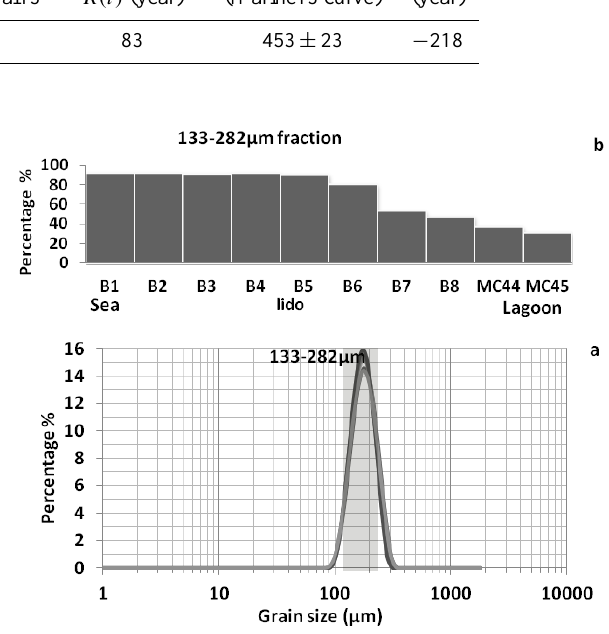
Figure 6. Grain size of lido sand in the Nador lagoon. (a) The spec- trum of the grain size percentages vs. grain size with unimodal dis- tribution (133 and 282µm). (b) Distribution of 133–282 fraction along sea–lagoon